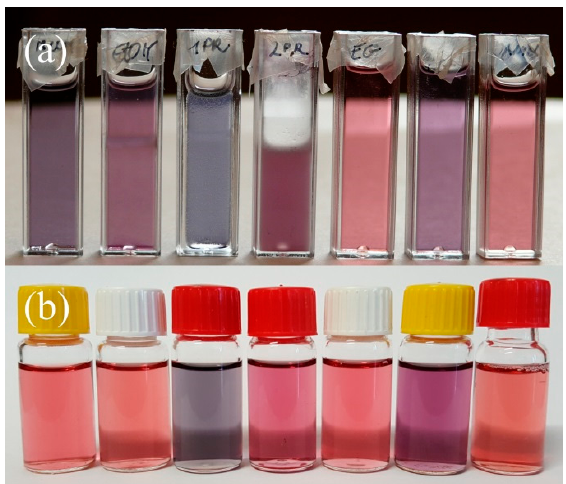
Figure 2. Photographs of the solutions containing 10 nm gold nanoparticles that were stabilized with citrate ions and diluted with an organic solvent (4 days of dilution): ( a ) in the parafilm-sealed cuvettes, very significant aggregation occurred, turning the solutions from red to grey or violet; ( b ) in the hermetically sealed sample vials, n-propanol and propylene glycol initiated strong aggregation, and the methanol solution remained unchanged.